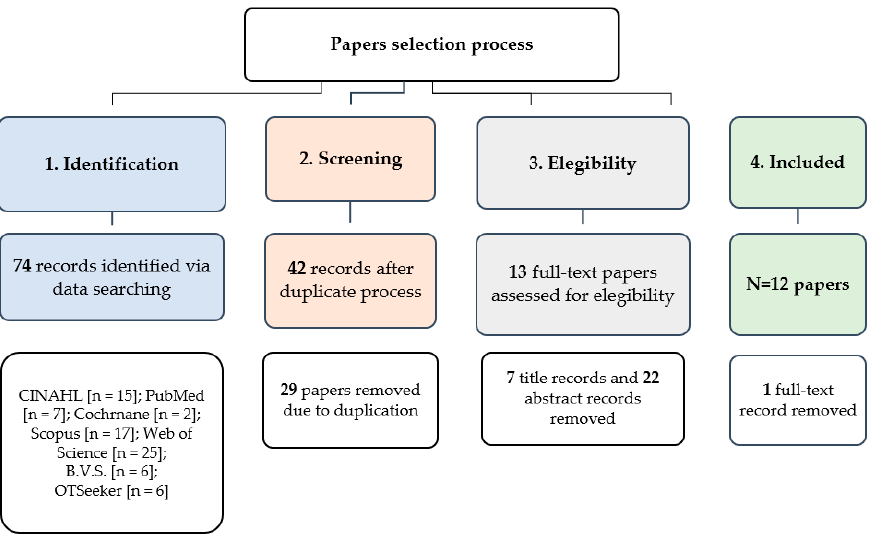
Figure 1. Flow diagram of the Scoping Review process .